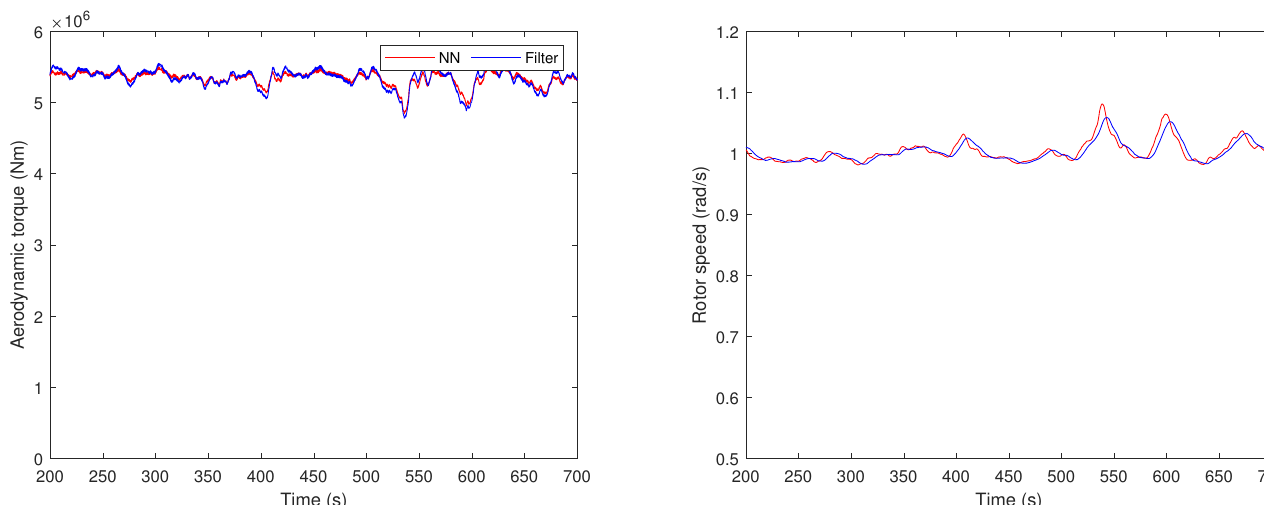
Figure 19. Output at a mean wind speed of 14 m/s (mode